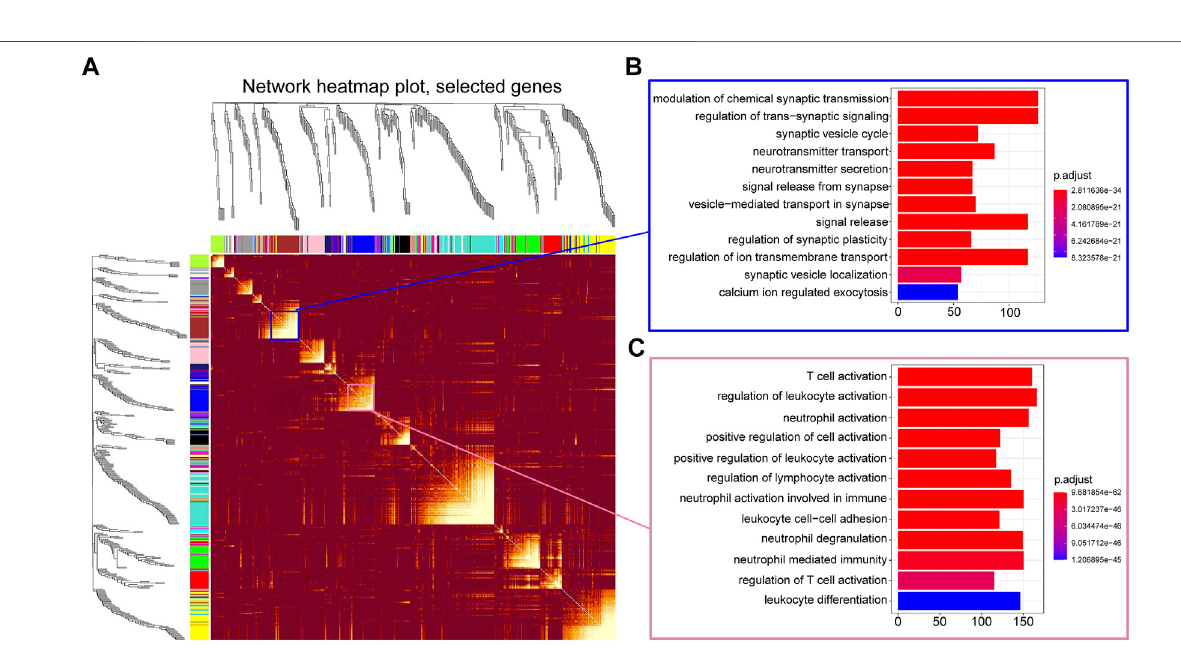
Frontiers in Genetics |